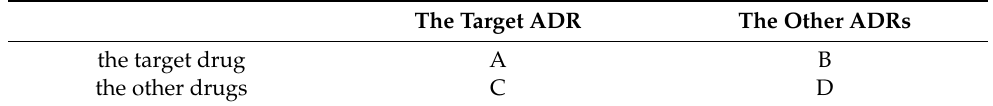
Table 1. Two-by-two contingency